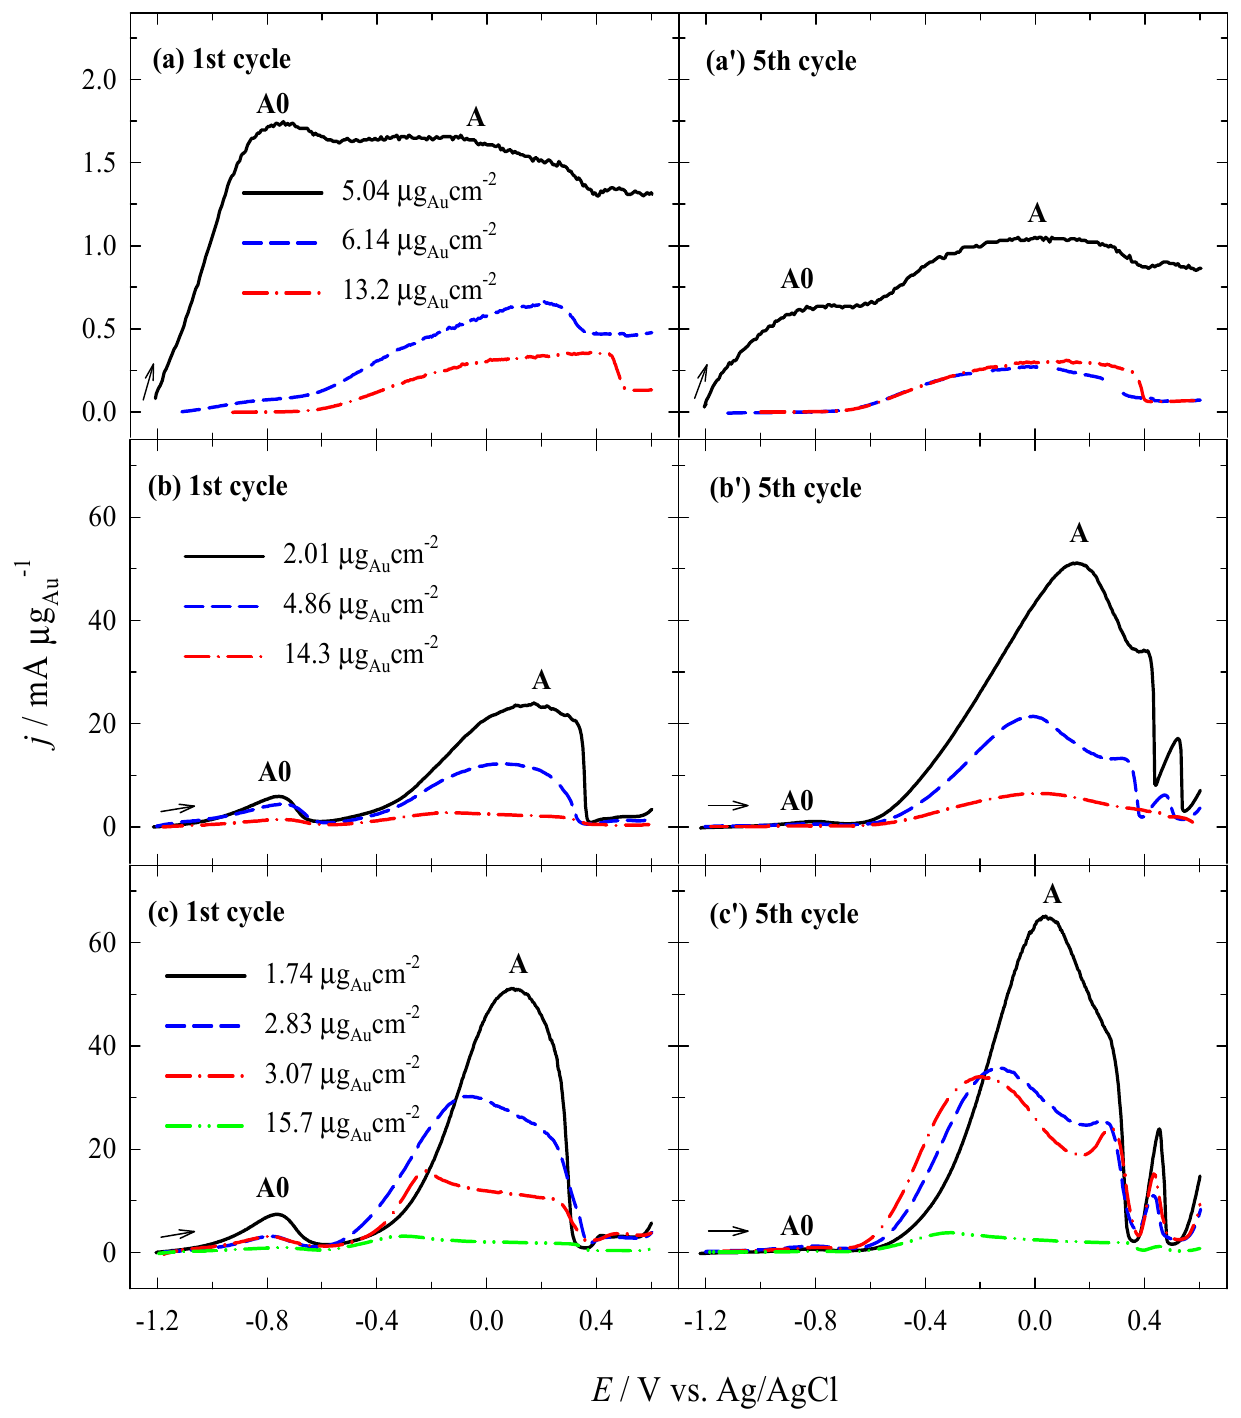
Figure 8. The mass-specific activity of the AuNi-TiO 2 ntb catalysts measured in a 0.05 M NaBH 4 + 1 M NaOH solution at 25 ◦ C at 10 mV · s − 1 : ( a ) the catalysts are the same—as in Figure 5, ( b )—as in Figure 6, and ( c )—as in Figure 7. ( a – c ) represent the 1st cycles and ( a’ – c’ )—the 5th